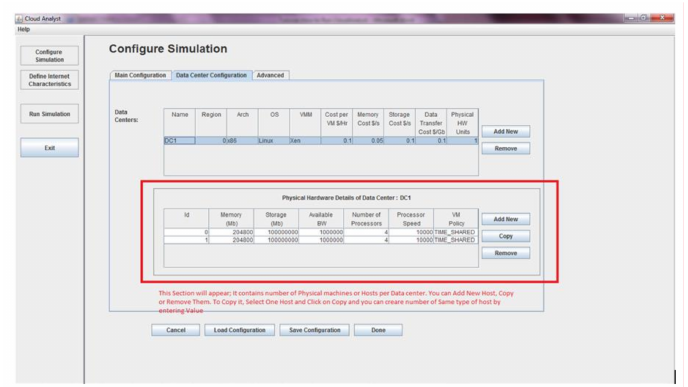
Figure 6. Parameter Setting in Cloud